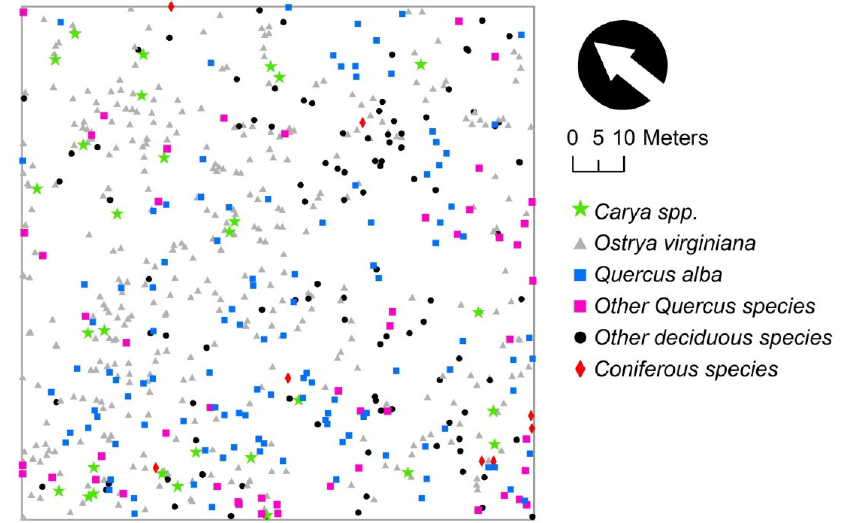
Figure 1. Map of the tree locations for the uneven-aged oak-hickory stand in Georgia (eastern United